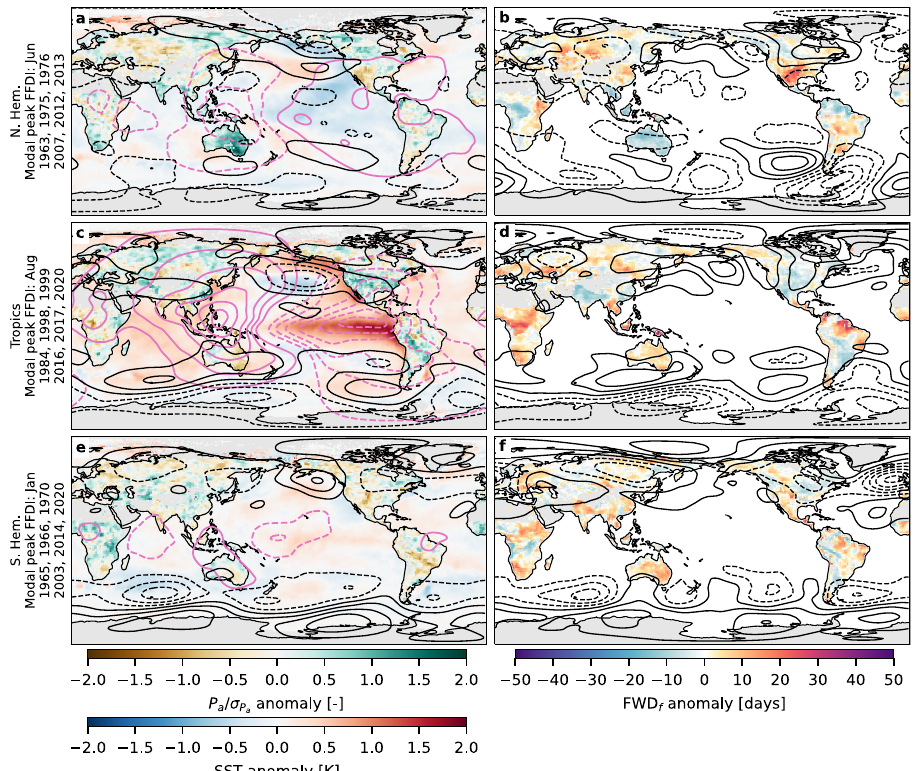
Fig. 5 Composites of spatially extensive preconditioned drought and fi re weather years. a Normalised antecedent precipitation ( P a = σ P brown and green shading), sea surface temperature (SST; red and blue shading), 500 hPa geopotential heights ( z 500 ; black contours starting at ± 5 m and spaced in intervals of 10 m) and 200 hPa velocity potential ( ϕ 200 ; pink contours starting at ± 5e5 m 2 s − 1 and spaced in intervals of 5e5 m 2 s − 1 ). The data are anomalies averaged over the six years listed to the left of the panel, selected as the 10% of years with the most widespread drought and fi re weather in the Northern Hemisphere. b As in ( a ) but for fi re weather day, FWD f , anomalies (shading) and three- monthly z 500 anomalies (contours starting at ± 5 m and spaced in intervals of 10 m). c – f As in ( a ) and ( b ) but for the tropics and the Southern Hemisphere. In all panels, precipitation and fi re weather data are for the “ fi re year ” ( L = f ) and “ antecedent ” ( L = a ) periods, respectively, which vary spatially (see the text and Fig. 1d). The period used for other variables in the left (right) column is the 12 (three) months ending (centred) on the most common peak FFDI month for the Northern Hemisphere (June), tropics (August), or Southern Hemisphere (January). Solid (dashed) contours indicate positive (negative)